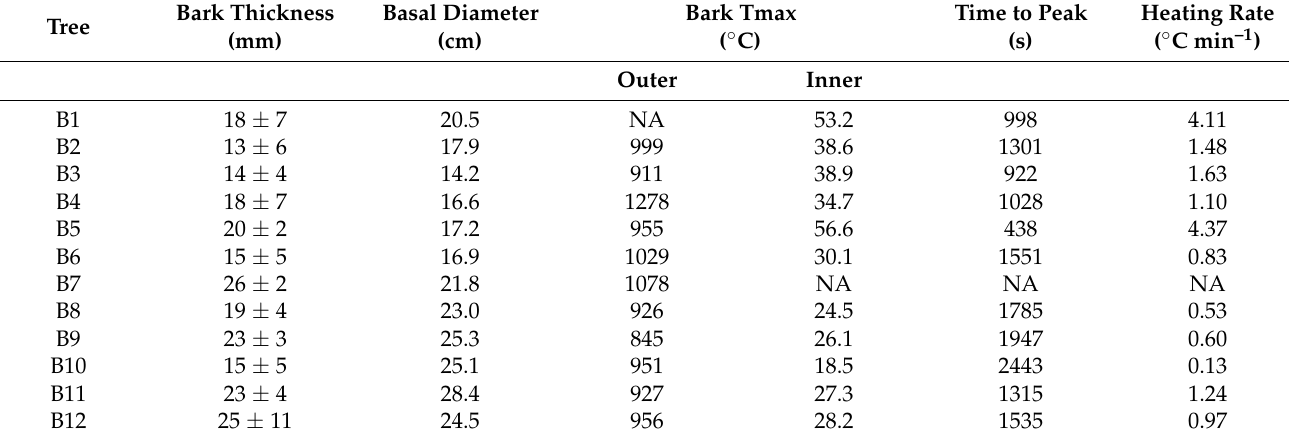
Table 4. The thickness of the bark, the basal diameter, the maximum temperature measured at the outer (air) and inner (cambium) bark, the time necessary to reach the temperature peak at the level of the cambium and the rate of heating between the outside of the trunk and the cambium, for each tree.